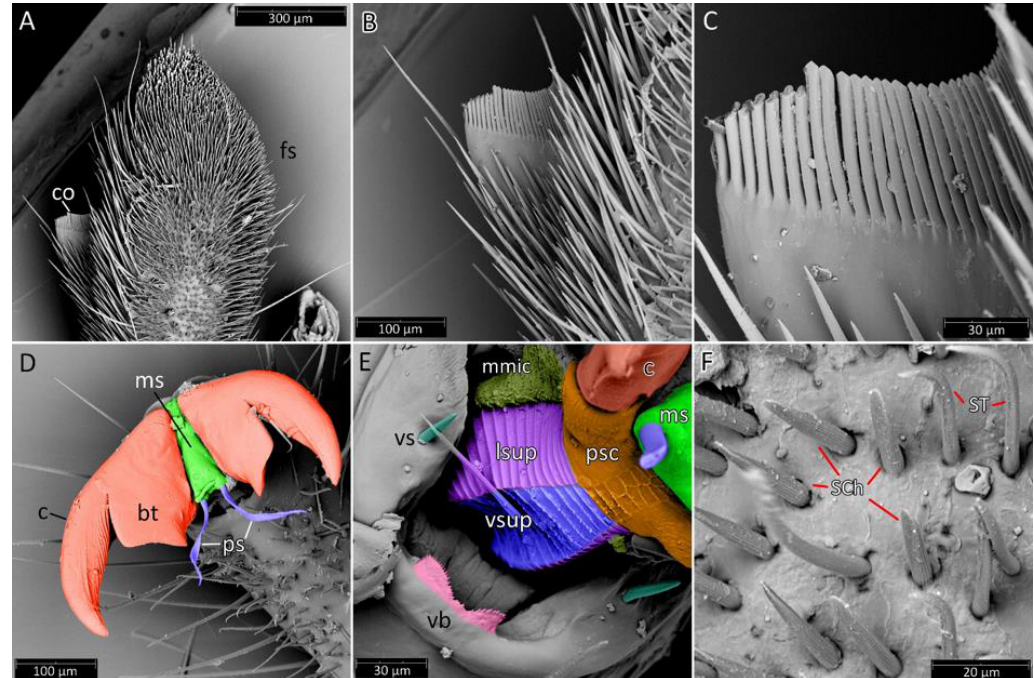
Figure 23. Phonoctonus elegans Varela, 1904: ( A ) foretibial fossula spongiosa, ventral view; ( B , C ) foretibial comb on the spur; ( D ) dorsal view of pretarsus. Phonoctonus lutescens (Guérin-Méneville & Percheron, 1834): ( E ) ventral view of the pretarsus. Phonoctonus immitis Stål, 1865: ( F ) sensilla trichoidea and sensilla chaetica at the dorsal surface of the third tarsomere apex. bt — basal tooth; c — claw; co — comb; dl — distal lamella; fs — fossula spongiosa; lsup — lateral surface of unguitractor plate; mmic — membrane with microtrichia; ms — median sclerite; ps — parempodial setae; psc — parempodial sclerite; ST — sensilla trichoidea; SCh — sensilla chaetica; vsup — ventral surface of unguitractor plate; vb — ventral brush; vs — ventrolateral seta of rim of distal tarsomere.